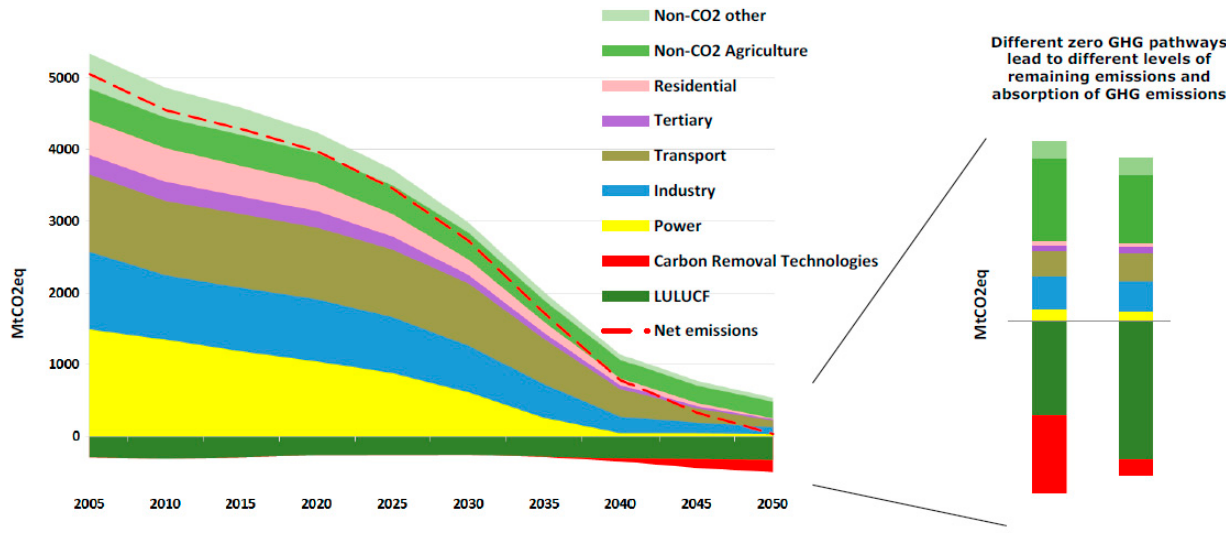
Figure 18. GHG emissions trajectory in a 1.5 °C scenario, bars represent the emissions and absorptions in 2050 of the 7th and 8th scenario, European Commission [211]. and 8th scenario, European Commission